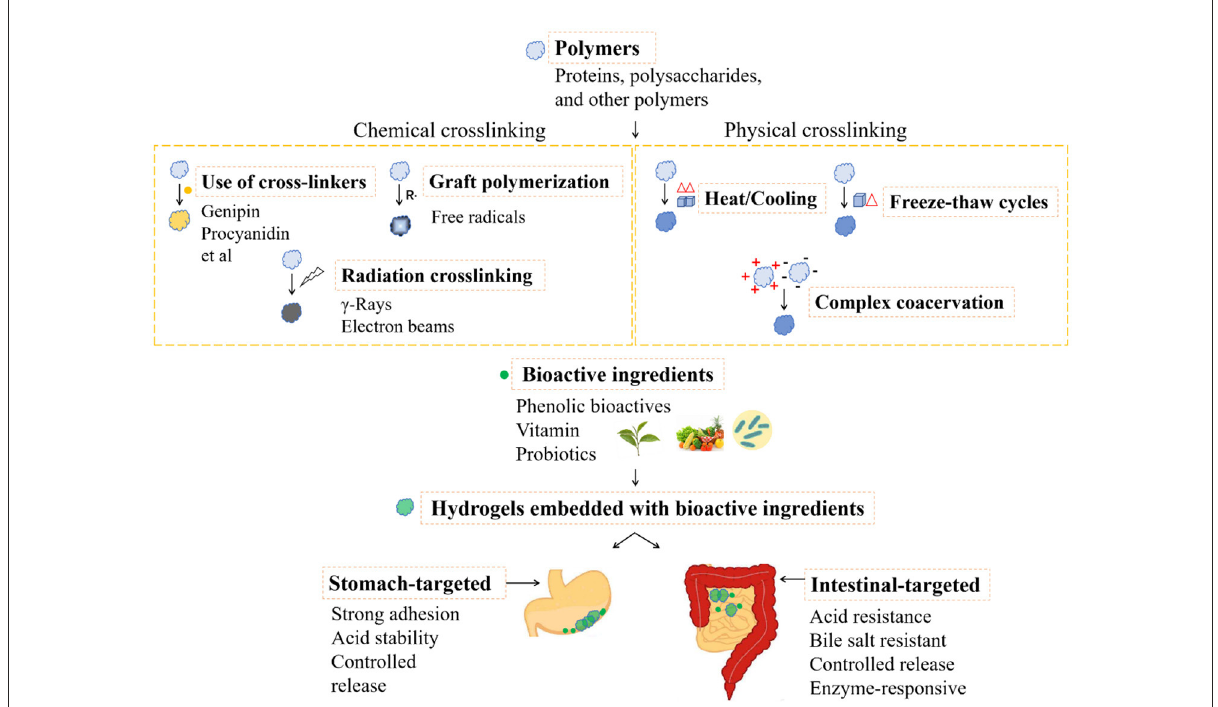
FIGURE5 The preparation and delivery of the food functional ingredients by hydrogels for oral